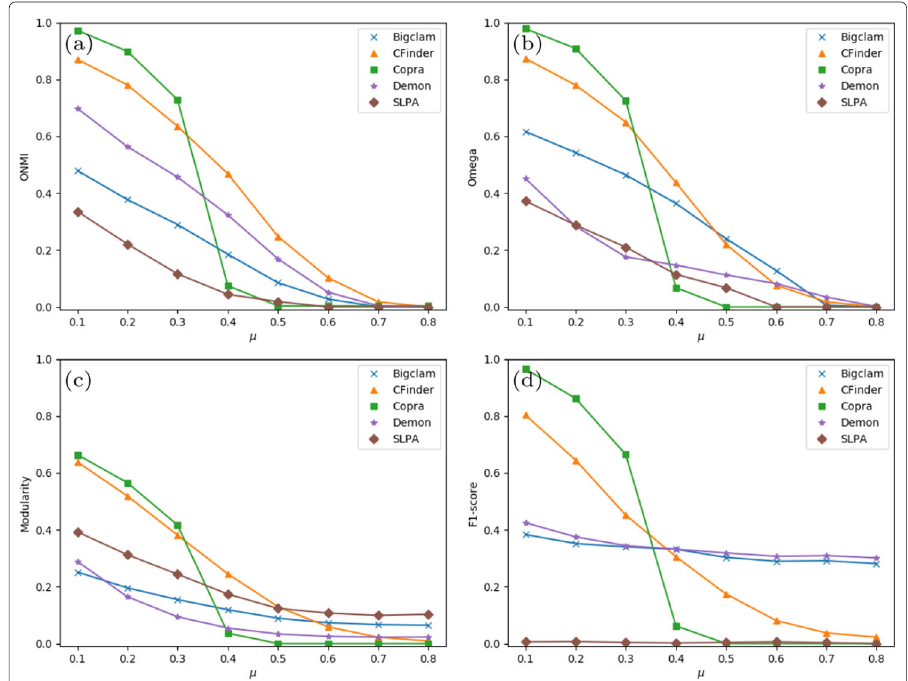
Fig. 8 Variation of the mixing parameter ( μ ) for LFR synthetic networks considering: a ONMI; b Omega; c Modularity and d